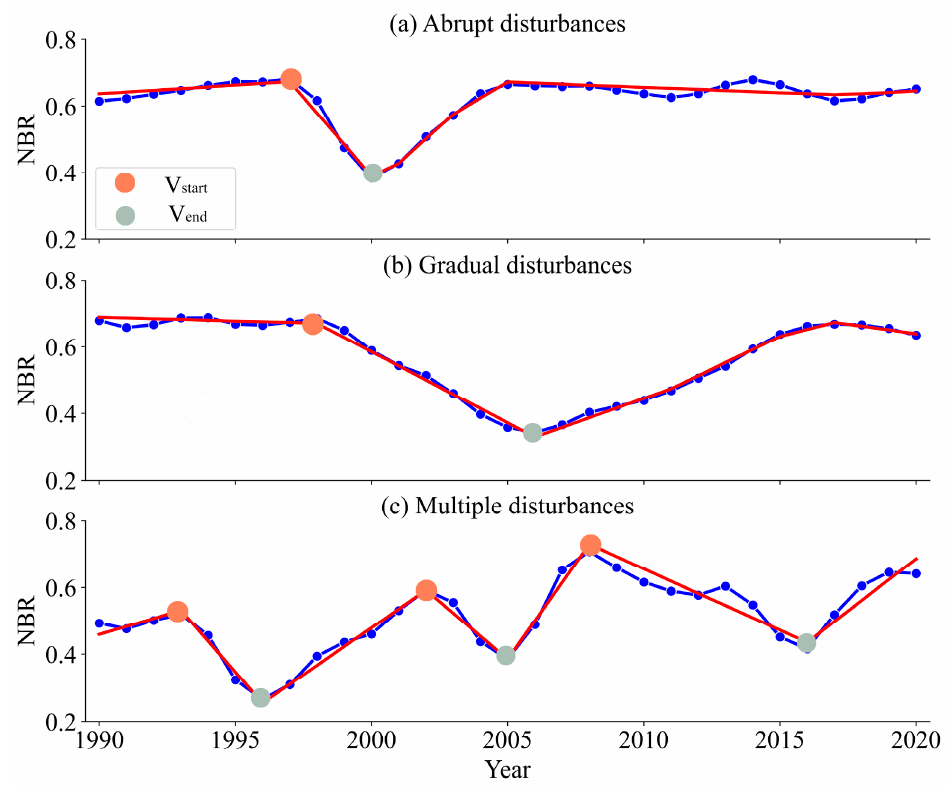
Figure 4. Types of forest disturbances in this study: ( a ) abrupt disturbances, ( b ) gradual disturbances, and ( c ) multiple disturbances.